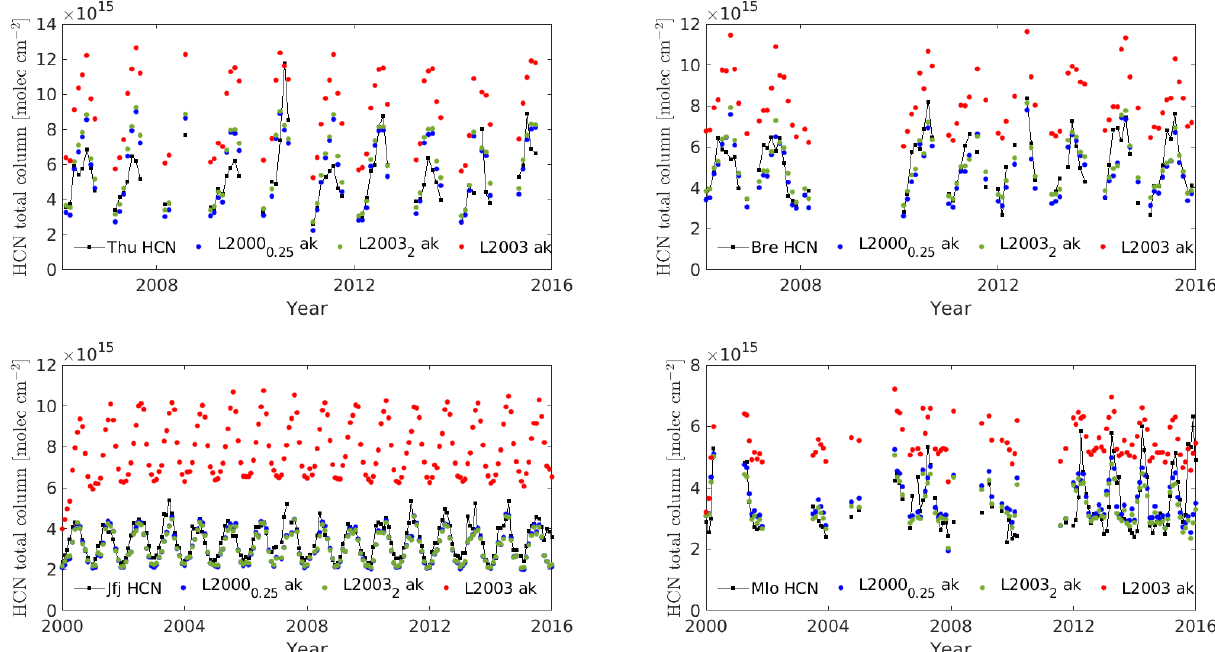
Figure 4. HCN total column time series (molec.cm − 2 ) measured at four NDACC stations (Thule (Thu), Bremen (Bre), Jungfraujoch (Jfj), and Mauna Loa (Mlo); black lines) and modelled by the L2000 0 . 25 (blue dots), L2003 2 (green dots), and L2003 (red dots) tracers (with averaging kernels applied; ak). Note the different time periods at the different